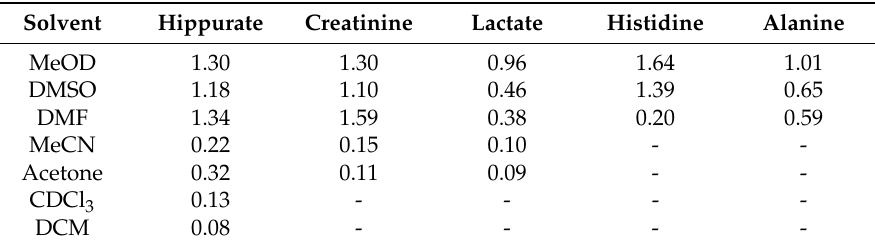
Table 2. Relative integrals to water as Table 2 . Relative integrals to water as solvent.